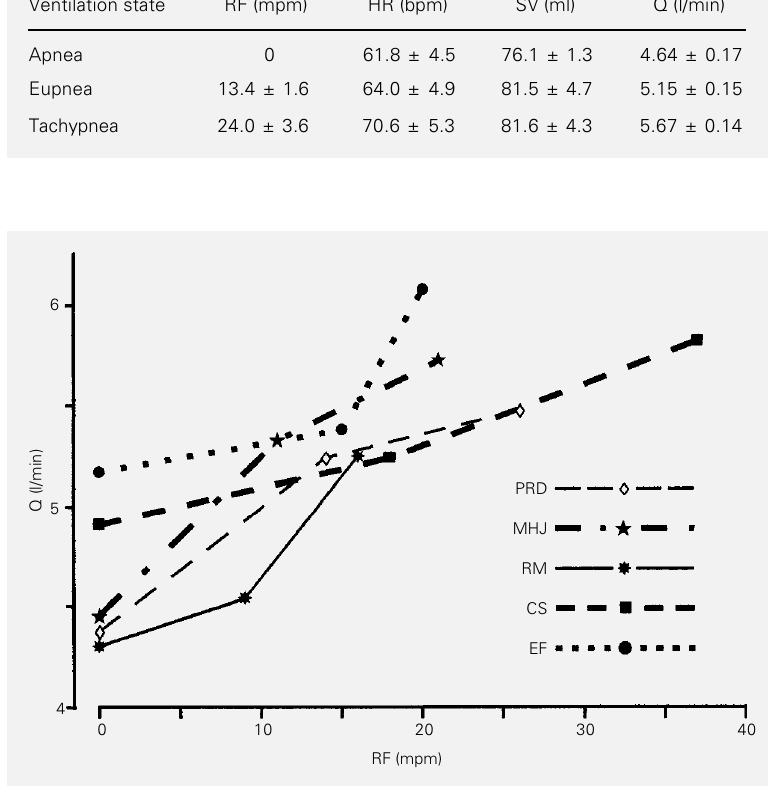
Figure 1 - Changes of systemic blood flow (Q) with respiratory frequency (RF) at apnea, eupnea and tachypnea measured by echodopplercardiography. Each line drawing corre- sponds to one